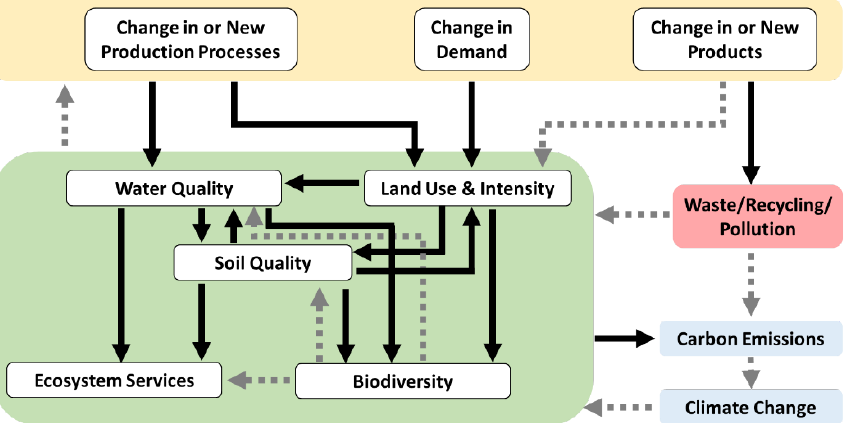
Figure 6. Overview of environmental impacts to be taken into account (black arrows), and indirect interdependencies (grey doted arrows) that excessively complicate environmental LCA. Adapted from [311,314 – 316].